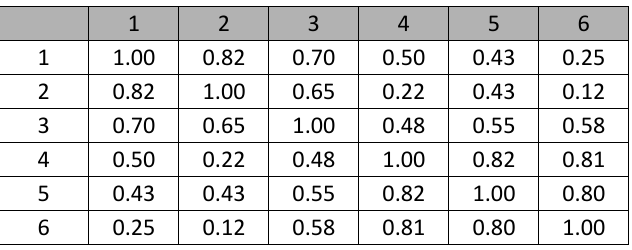
Table 2: Pearson correlation coefficients between different different habitat type